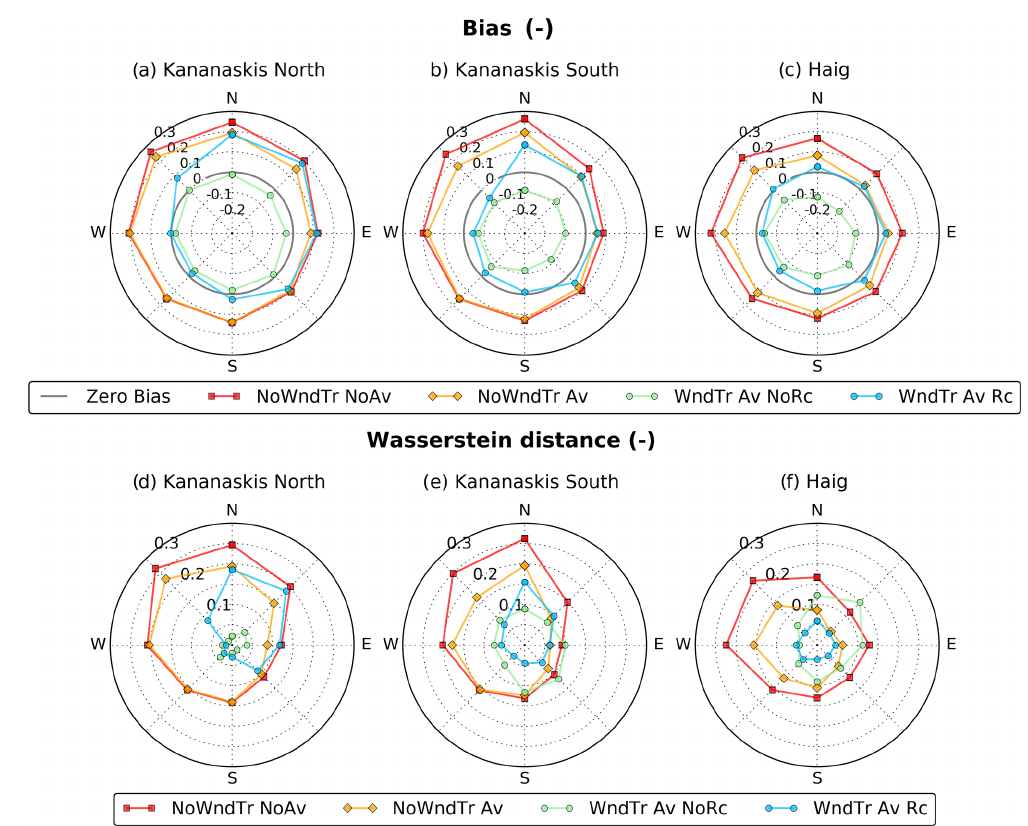
Figure 12. Same as Fig. 9 but for the snow persistence index